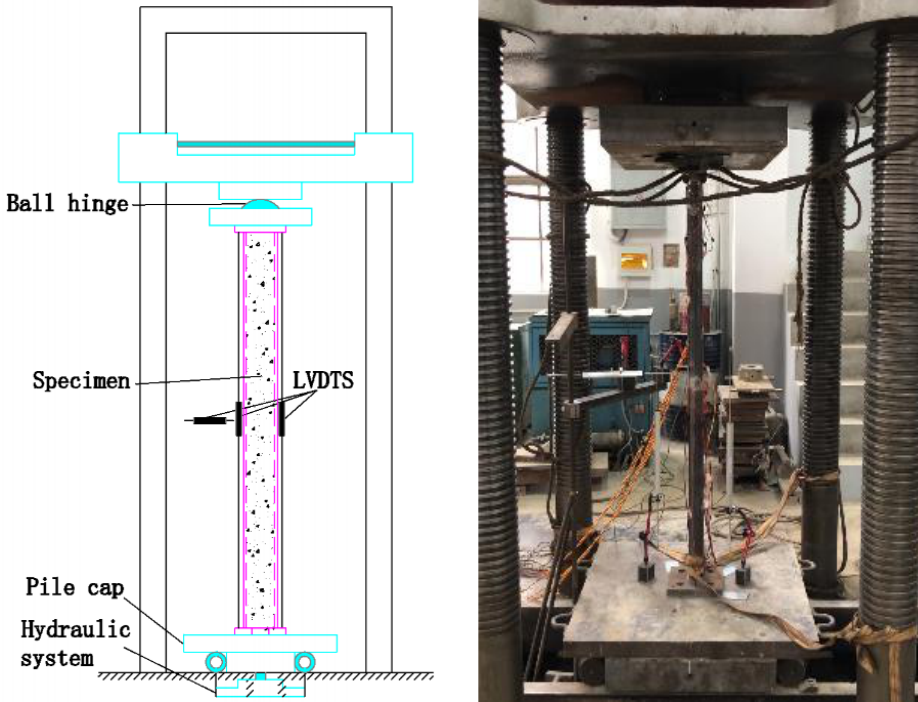
Figure 8. Test setup.